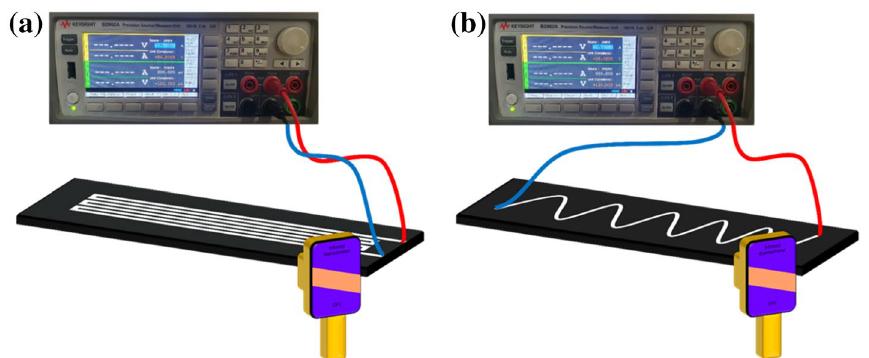
Fig. 3 Testing of a heating layer model and b SMA